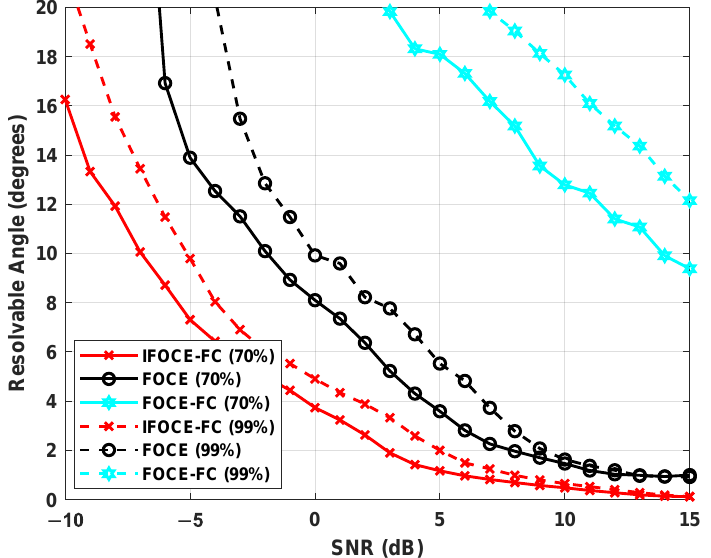
Figure 8. Comparison of different algorithms for the resolvable angle versus the SNR in the ULA application.